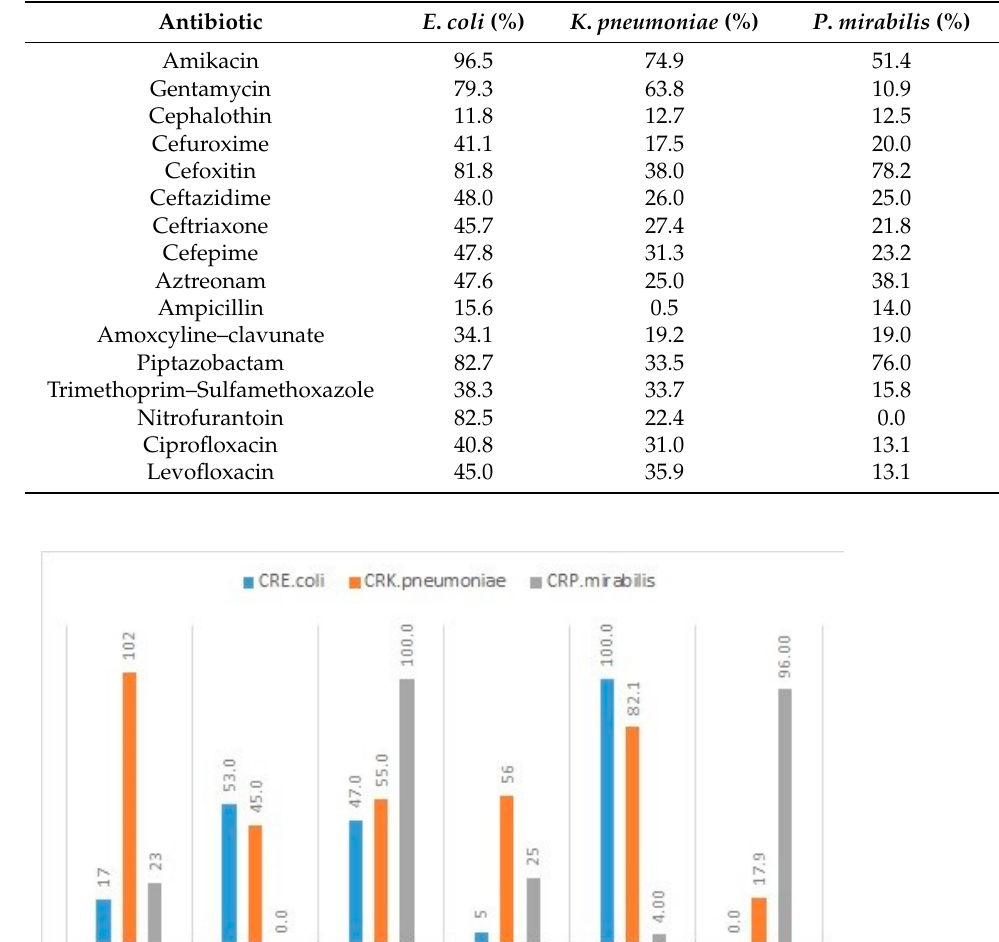
Table 5. Antimicrobial sensitivity of the studied organisms.